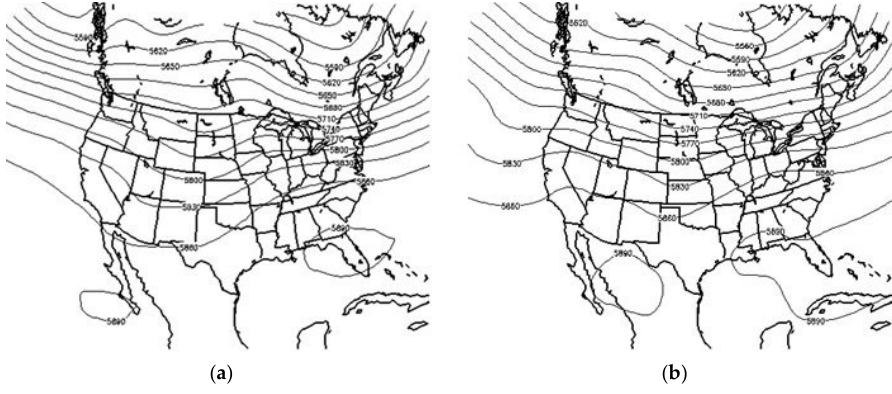
Figure 4. The 500-hPa geopotential heights (dkm) every 30 dkm from 5500 to 6000: ( a ) composites for elevated convection; and ( b ) composites for surface based convection.